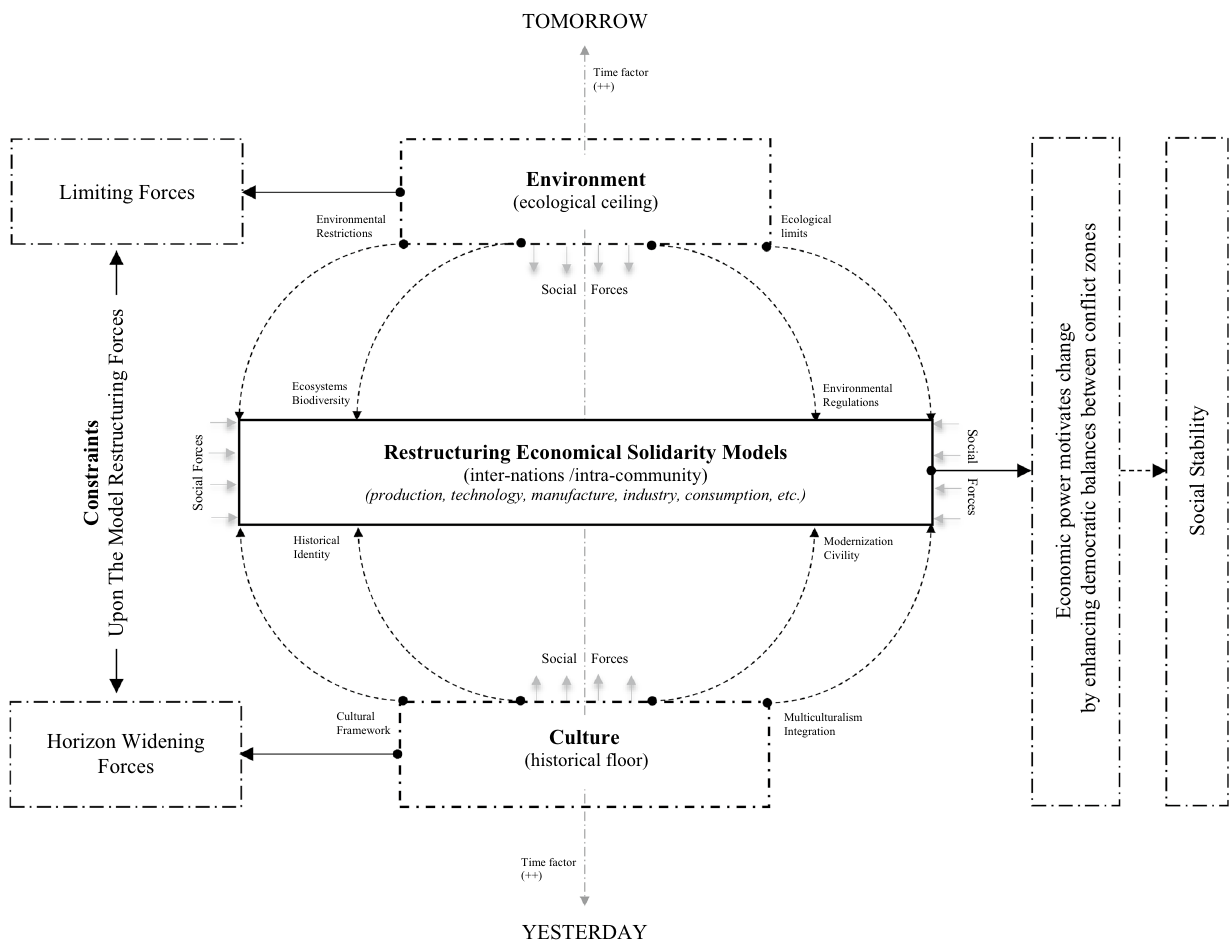
Fig. 8 Model 5: Economical outline model of utopian sustainability